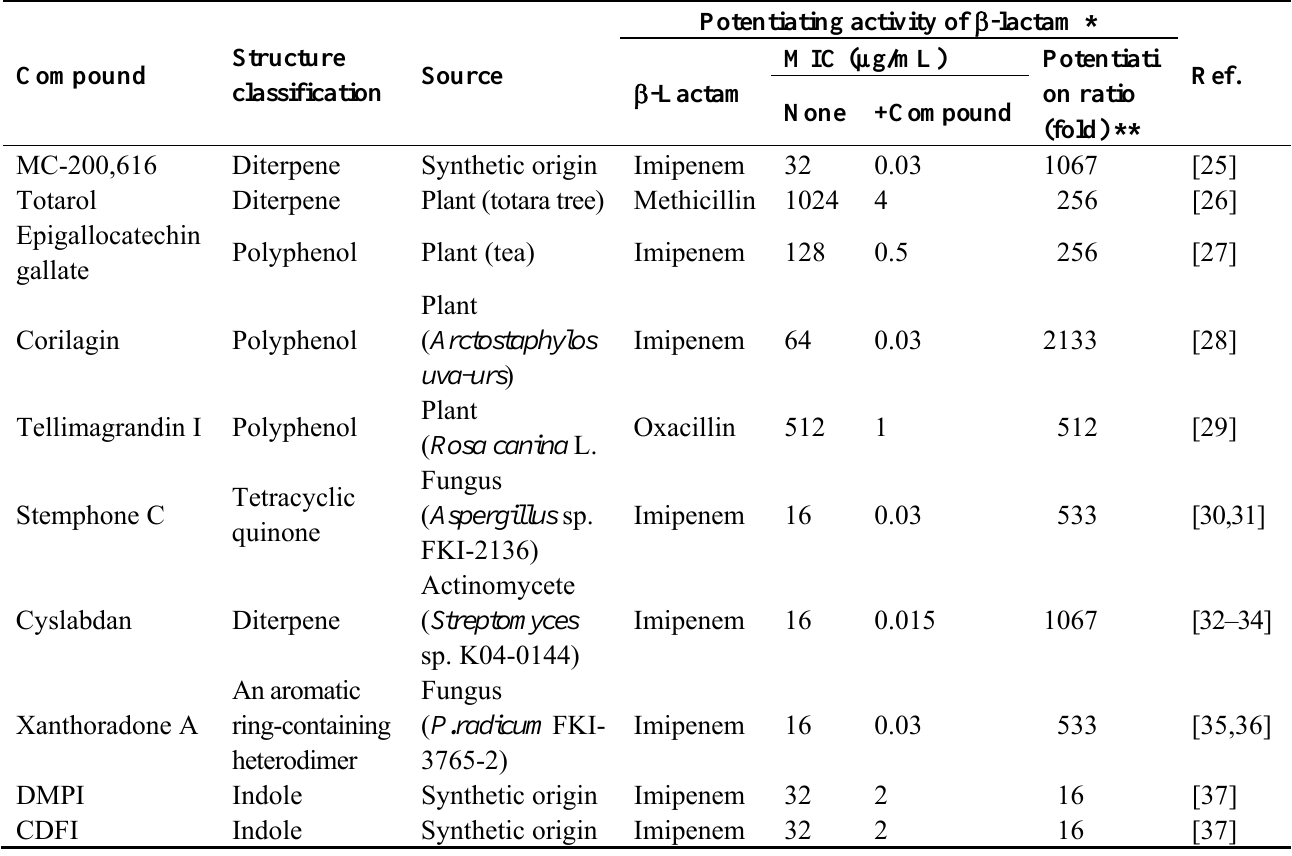
Table 2. Activity of β -lactam potentiators against